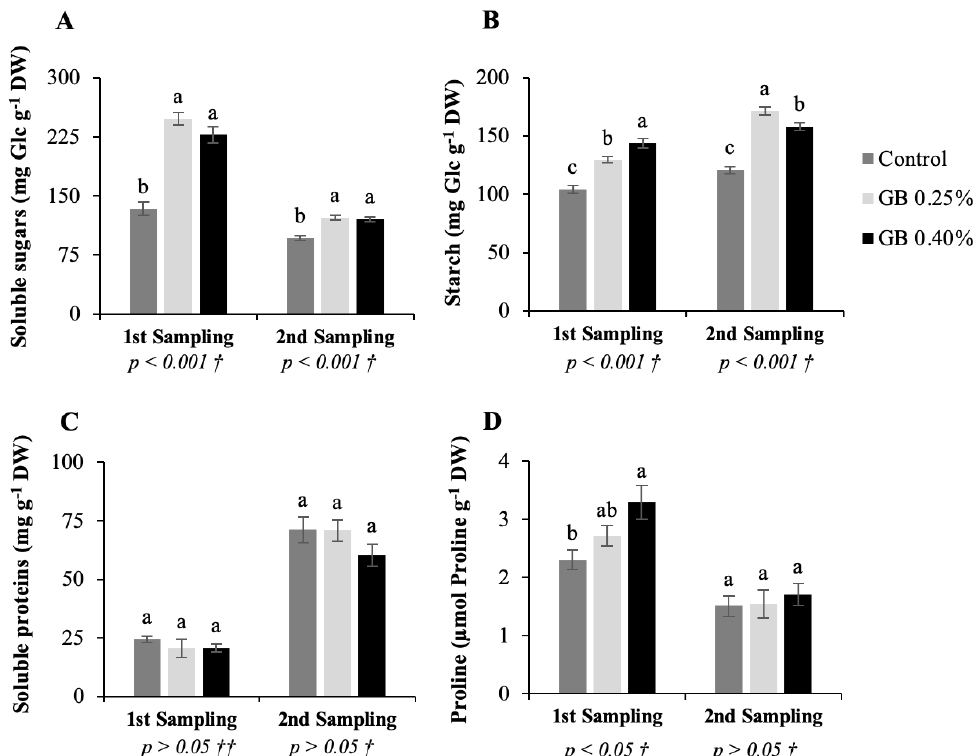
Figure 5. Represents soluble sugars, starch, soluble proteins, and proline concentrations in sweet cherry tree leaves. Soluble sugars ( A ), starch ( B ), soluble proteins ( C ), and proline ( D ) contents, for the cv. Lapins leaves subjected to the different treatments. † Indicates that the p values were calculated from the one-way ANOVA analysis after verifying the assumptions of normality and homogeneity of variances. When a significant effect was observed ( p < 0.05), Tukey’s post-hoc test was applied. †† The p values were calculated from the One-way Welch Analysis, since the homogeneity of variances was not verified. When a significant effect was observed ( p < 0.05), the Dunnett T3’s test was applied.